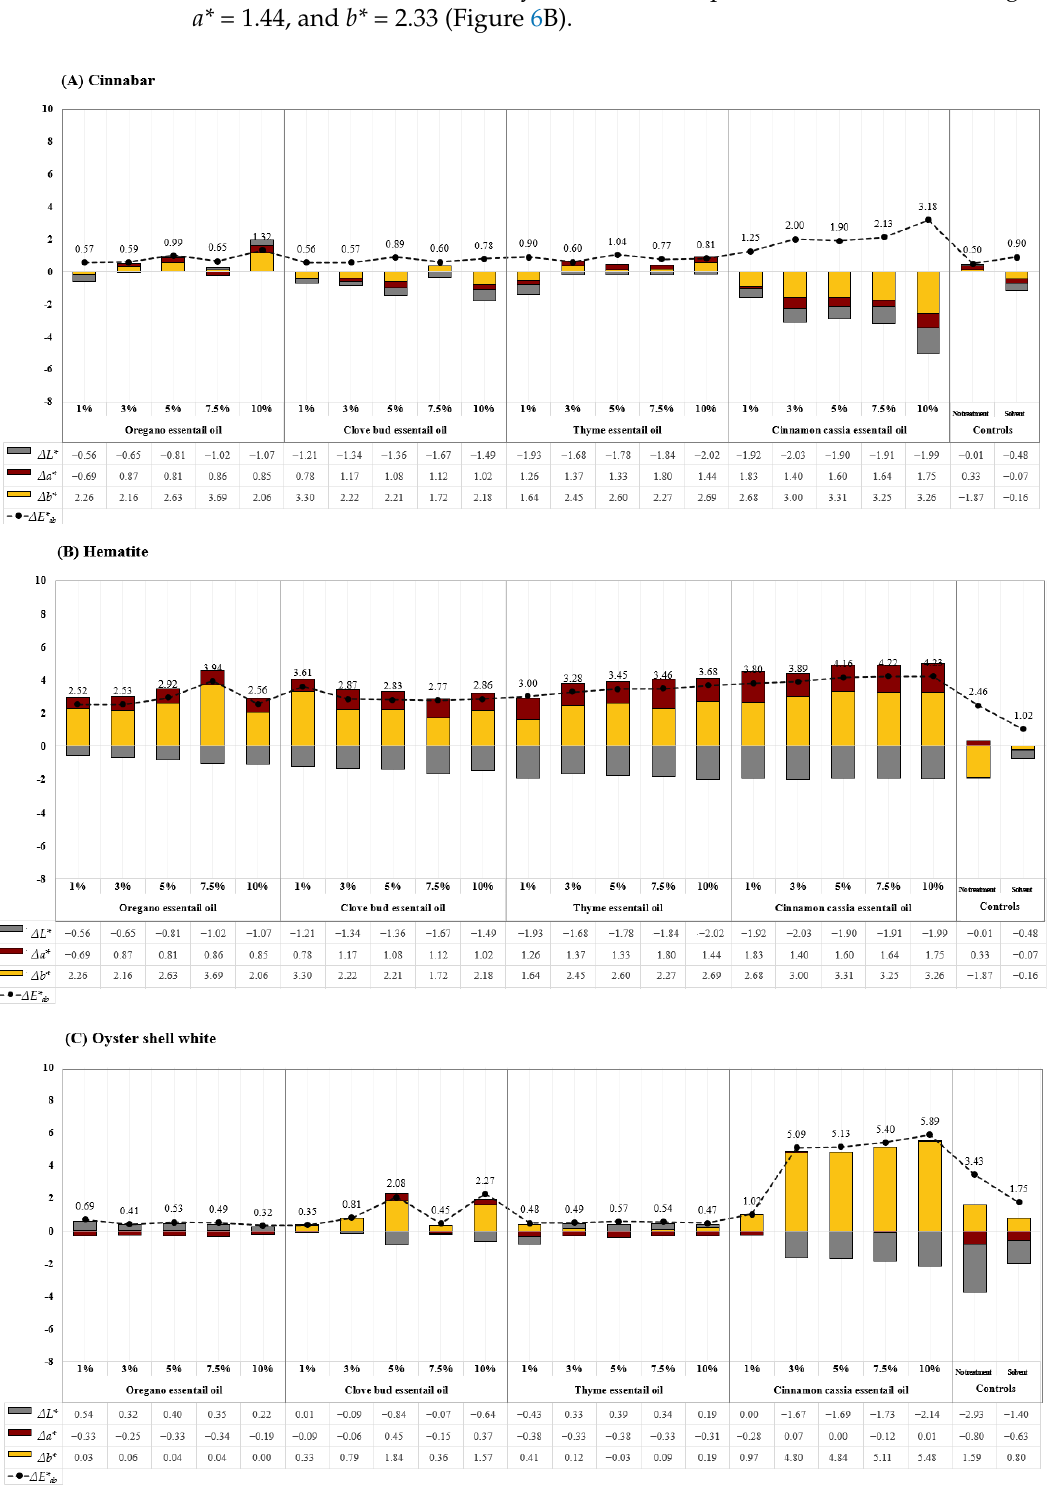
Figure 6. Color difference values ( ∆ L *, ∆ a *, ∆ b *, and ∆ E * ab ) before and after treatment of pigment specimens with low-concentration essential oils.